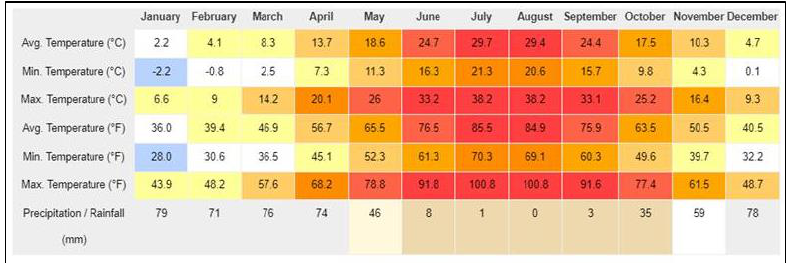
Figure 2. The average temperature measurements per month for Diyarbakır [14].